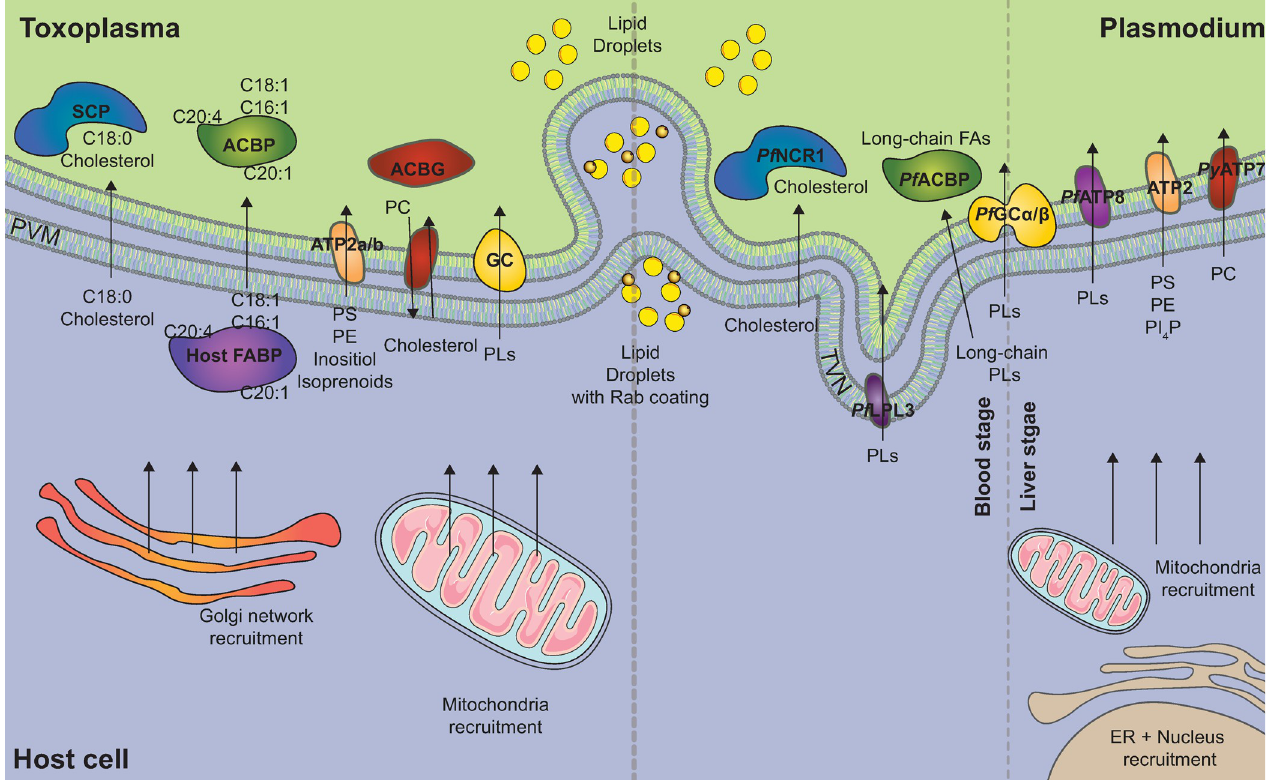
Fig 3. Scavenging mechanisms known in T . gondii (left) and Plasmodium sp. (right) parasites. Toxoplasma (left): T . gondii infection displays active recruitment of the host Golgi network and mitochondria to the parasite and is important in nutrient scavenging. Host lipid droplets can be endocytosed into the parasite through the PVM due to their Rab7 coating. Rab vesicles also facilitate the formation of the intravacuolar network found in the PVM. Stearic acid (C18:0) and cholesterol are taken up from the host via an SCP and host FABPs and parasite ACBPs modulate the importation of acyl chains into the parasite and to specific organelles. ABCGs are responsible for the influx/efflux of PC and cholesterol between the host and the parasite. Other lipid transporters are responsible for the scavenging of PS, PE ( Tg P4-ATPase1-3), choline, sphingolipids, inositol, and isoprenoids; all involved in lipid metabolism. GC is an atypical flippase whose exact mechanism is not yet known but is proposed to be a PL transporter. Plasmodium (right): Lipid droplet scavenging occurs in a similar manner to that in Toxoplasma parasites. Malarial infection displays active recruitment of the host ER/nucleus and mitochondria to the parasite (not in blood stages). It is suspected that Pf NCR1 is important in cholesterol transport from the host. Pf LPL3 localized to the intravacuolar TVN. Pf LPL3 allows to hydrolyze host phospholipids to generate FA then used for DAG/TAG formation 3 Pf ACBPs have been identified that show an affinity to transporting